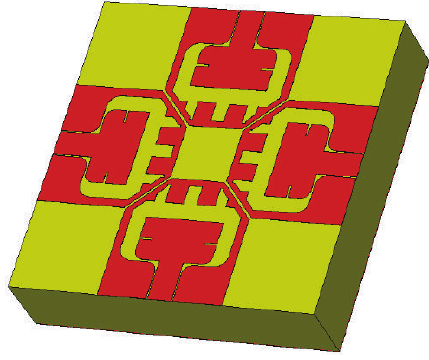
Figure 23: Dual-polarized UWB subarray [47].